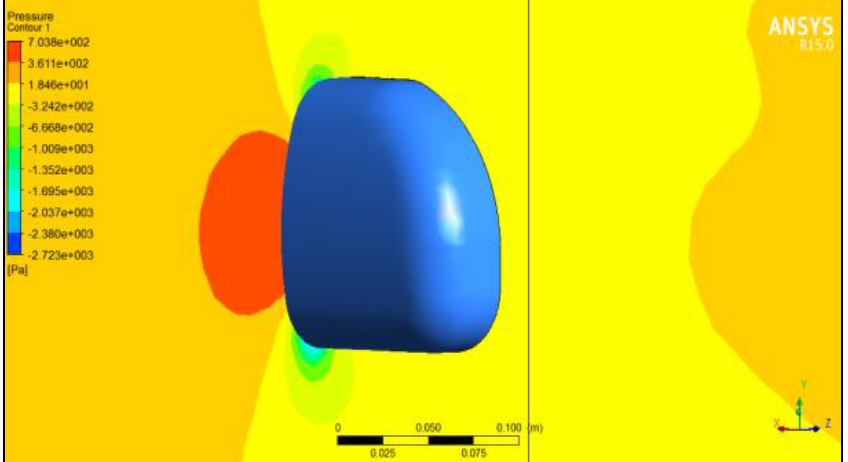
Figure 14. Pressure contours in curent mirror (120 km/h)